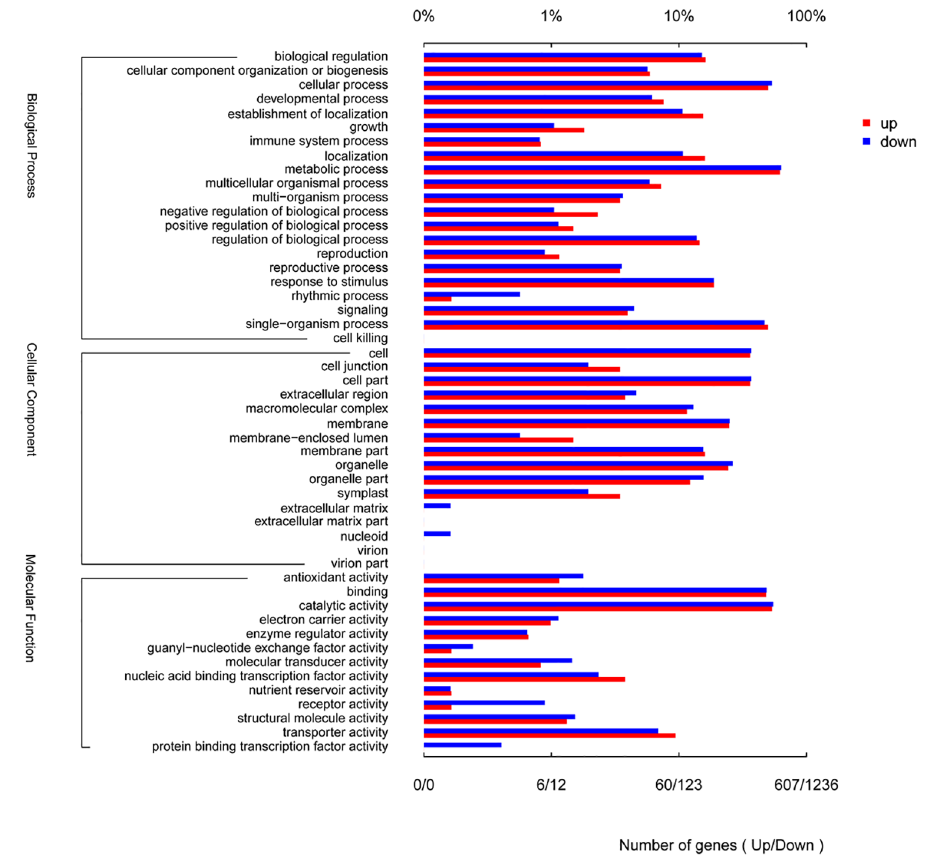
Fig 6. GO annotation of up- and down-regulated expression genes of coYP versus coGS.